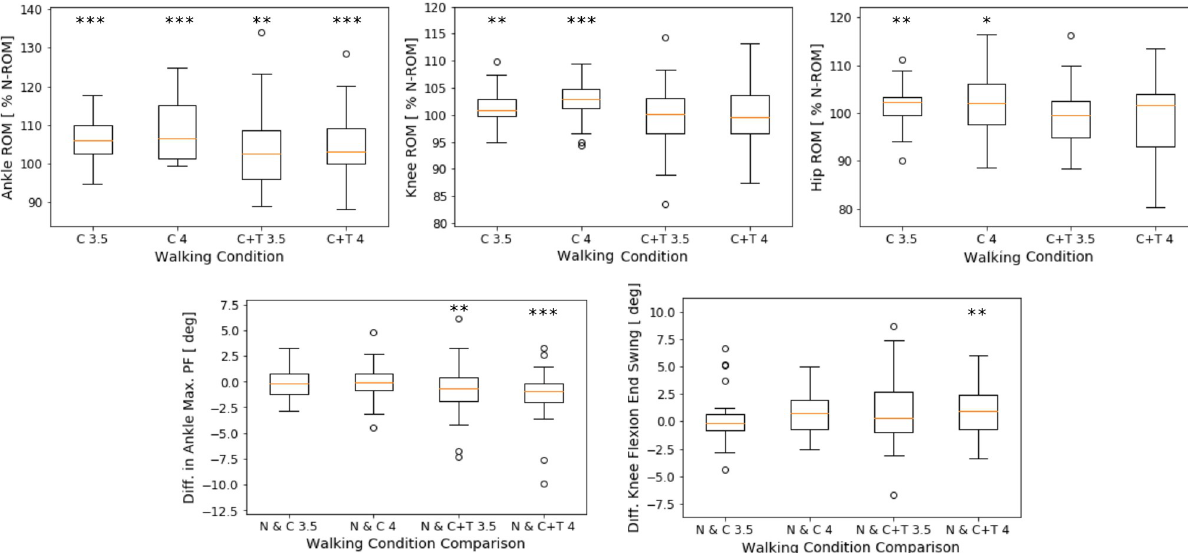
Fig 2. Joint motion between subjects. (Upper row) Joint ROM during C-restriction (C) and CT-restriction (C+T), at 3.5 km/h and 4 km/h walking speeds, expressed as a percentage of the ROM during normal walking. (Lower row) Difference between restricted (C, C+T) and normal walking (N) in the maximum ankle plantar flexion and knee flexion at the end of the swing phase. A negative value indicates that the respective parameter decreases during restricted walking. ��� p < 0.01, �� p < 0.05, and � p < 0.1 indicate significant differences with normal walking. The edges of the box plot correspond to the 25-th and 75-th percentiles, and the single points (outliers) correspond to the respective parameter values that were distant from the general tendency.